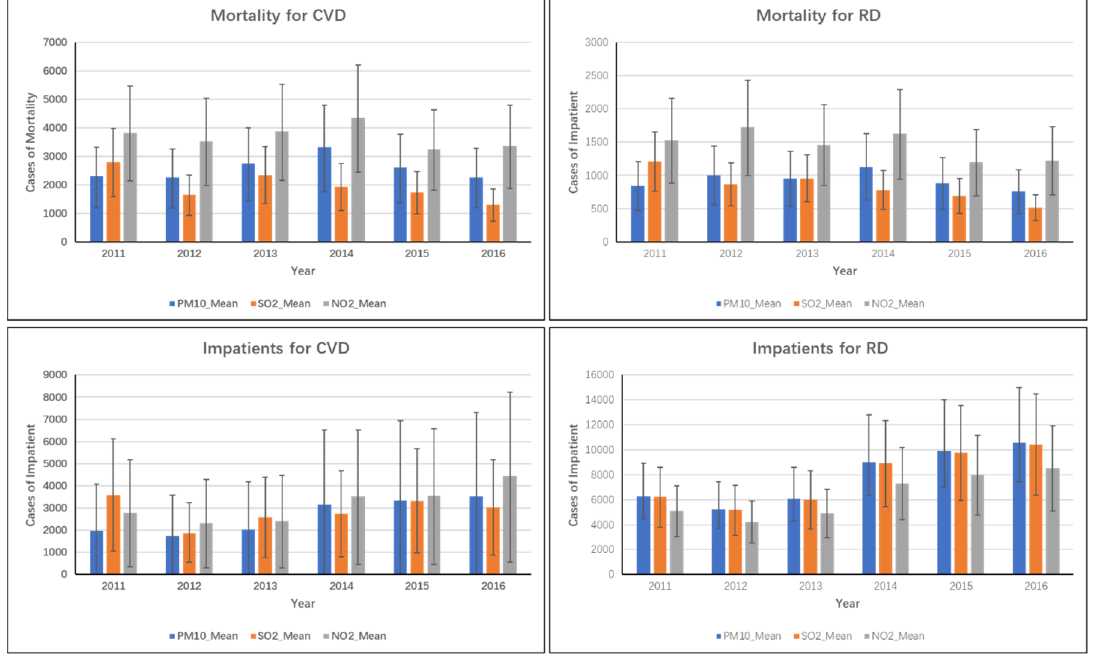
Figure 3. Cardiovascular and respiratory mortality and morbidity caused by air pollutants.